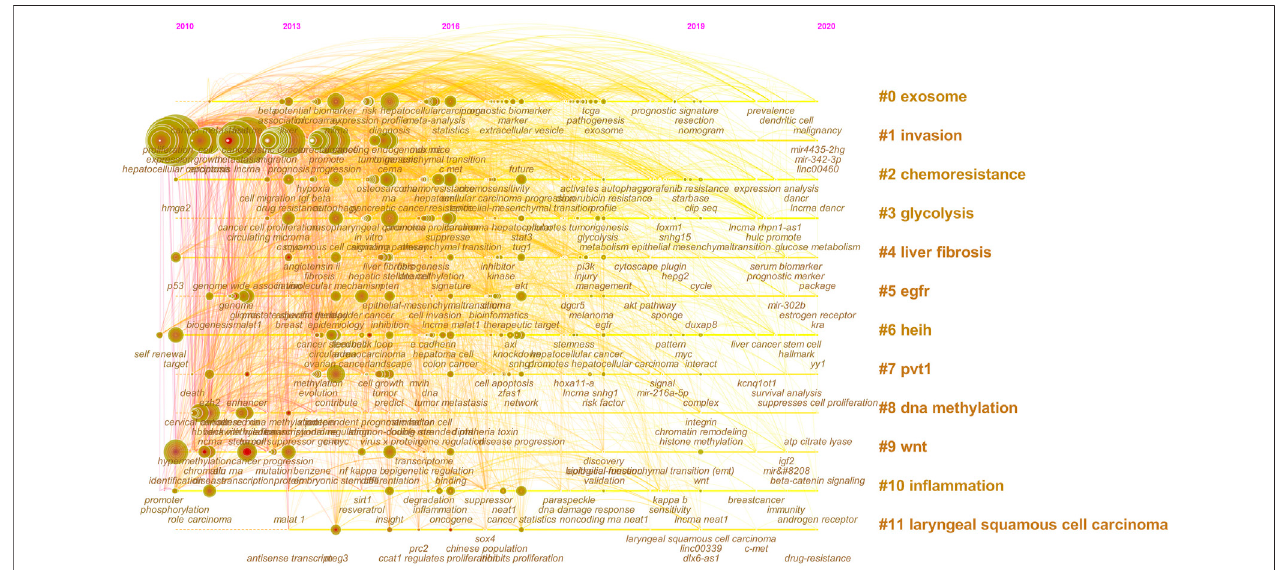
FIGURE 7 | The timeline view of the knowledge map in lncRNAs and